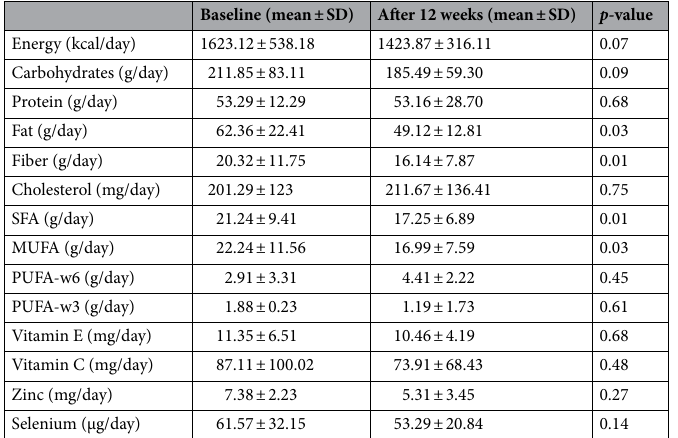
Table 2. Energy intake and nutrient consumption of participants at baseline and after 16 weeks of